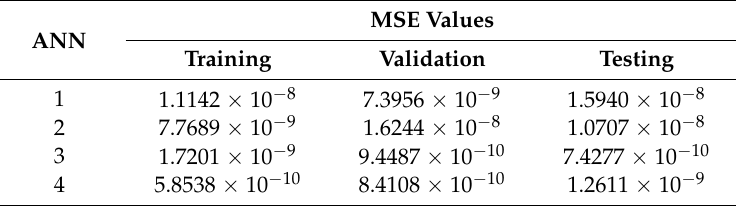
Figure 8. GAANN architecture for GyroWheel rate sensing. Table 5. MSE performance of GAANN models.